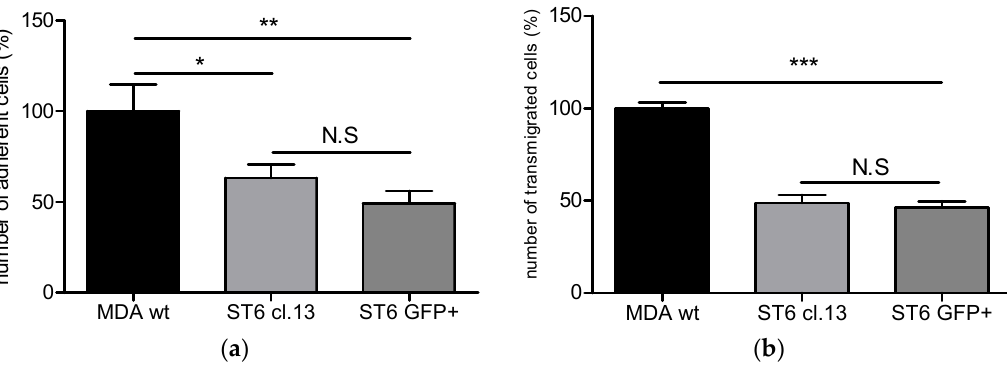
Figure 4. Adhesion ( a ); and transmigration ( b ) of MDA-MB-231wt, Clone #13 (ST6 cl. 13), and GFP+ breast cancer cell population (ST6 GFP+) on the human Brain-Like endothelial Cells (BLECs) model. The number of adherent or transmigrated MDA-MB-231 wt cells was set up to 100% and equal to, respectively, 533 and 117 cells. Results are the mean in triplicate, and representative of two or three independent experiments. N.S: not significant; * p < 0.01; ** p < 0.005; *** p < 0.001.